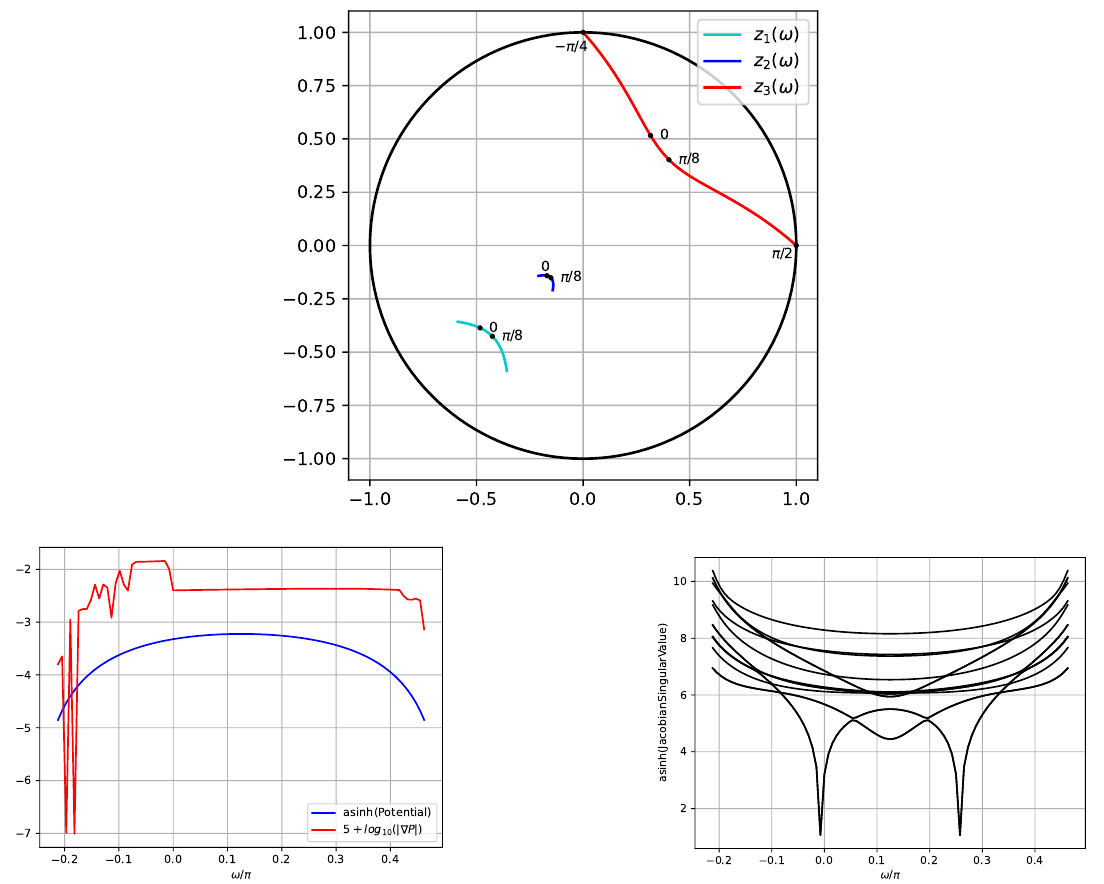
Figure 1. ω -deformation of the SO(3) N = 1 equilibrium of the de Wit-Nicolai model on the M := (SU(1 , 1) / U(1)) 7 submanifold of M . Top: evolution of the z parameters on 14 70 1 , 2 , 3 the Poincare disc as a function of ω . The ω -trajectory is symmetric around ω = π/ 8 . Left: asinh-“squashed” Potential and shifted log-scale stationarity-violation (gradient of the potential). This diagram shows that the potential is monotonic in | ω | , and that ODE-integration always kept the numerical stationarity-violation < 10 − 6 , indicating reasonably good numerical quality of results. Right: asinh-squashed singular values of the 70 × 14 Jacobian of the potential. Both the level-crossing avoidance and the observation that singular values do not reach down to zero are limited-resolution